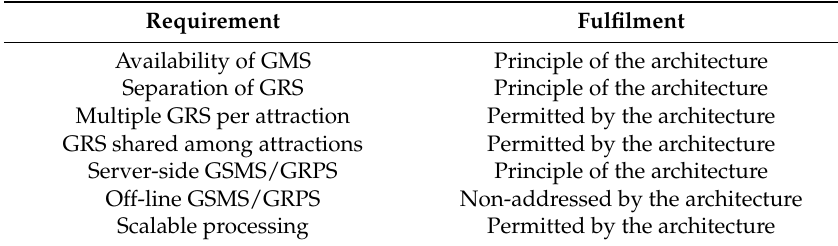
Table 4. Fulfilment of tourist attraction needs by the proposed architecture.